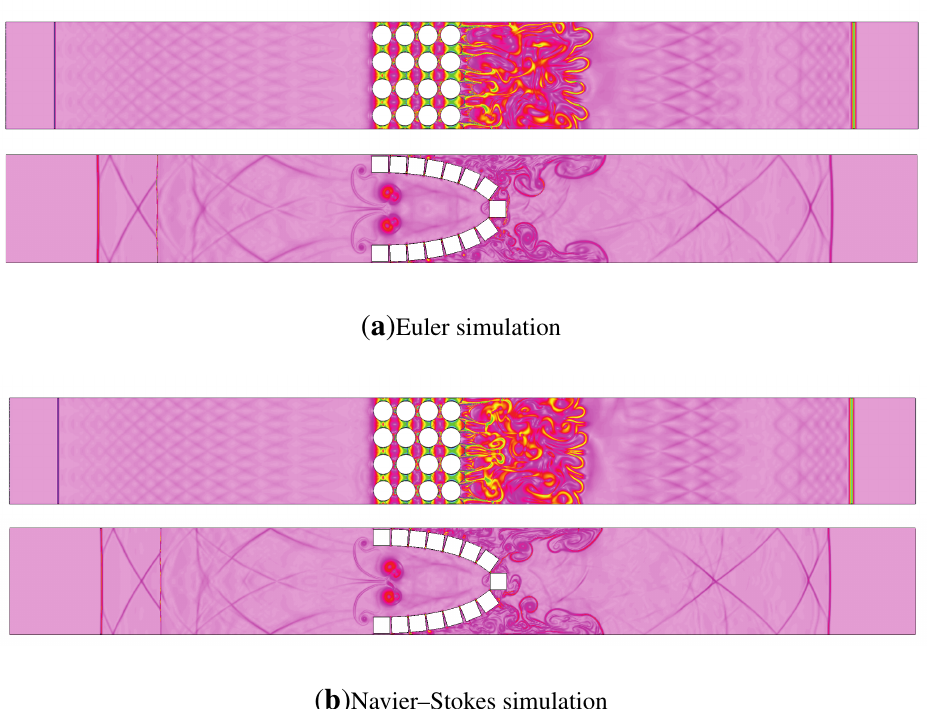
Figure 4. Schlieren contour for shock wave propagation past non-staggered cylinder matrix and squares along a logarithmic spiral under ( a ) inviscid Euler equations and ( b ) full Navier–Stokes